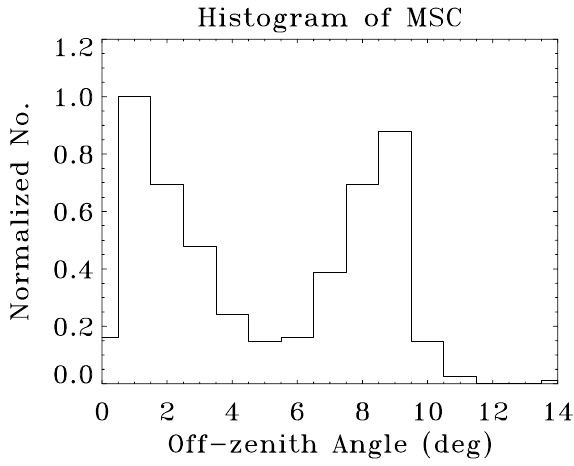
Fig. 9. Histogram of scattering centers for the multiple-scattering- center